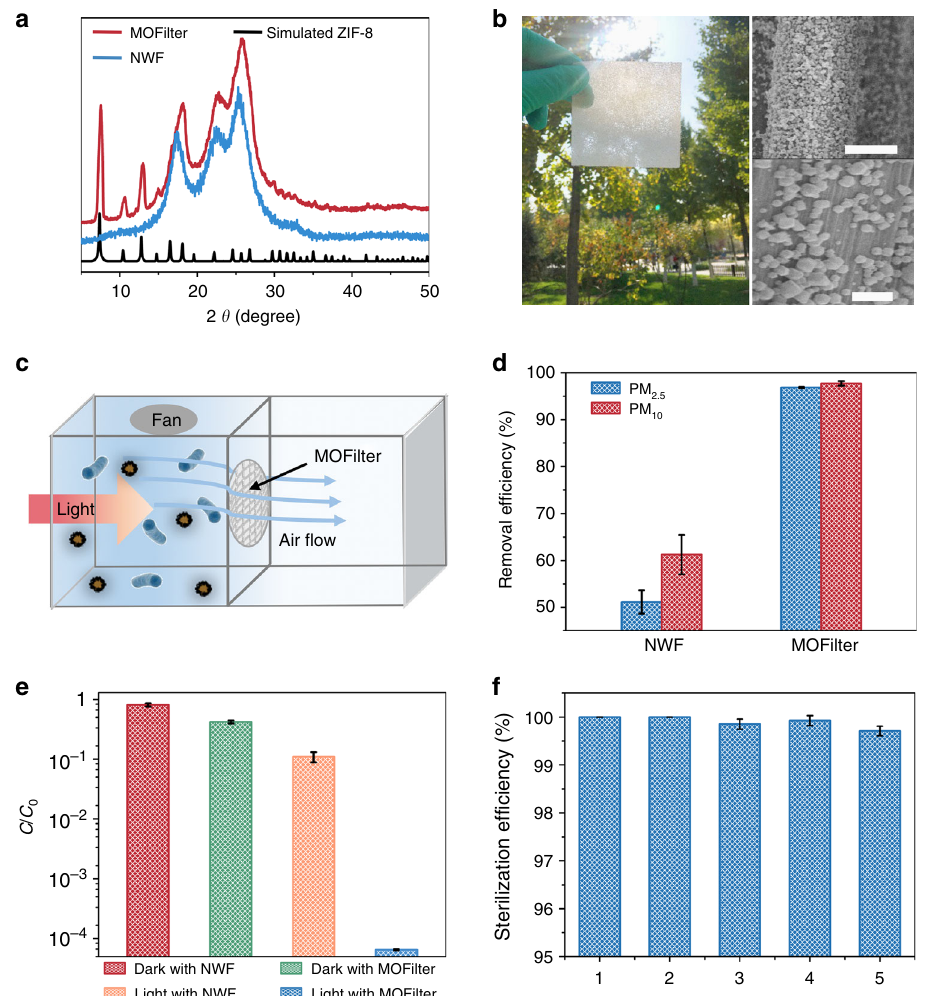
Fig. 4 Characterization of metal-organic framework (MOF)-based fi lter (MOFilter) and its air cleaning performance. a X-ray diffraction (XRD) patterns of non-woven fabric (NWF) and MOFilter. b Optical photo and scanning electron microscopy (SEM) images of MOFilter (scale bar, 5 μ m (top); 1 μ m (bottom)). c Schematic representation of the air cleaning system. d Comparison of the particulate matter (PM) fi ltration ef fi ciency between MOFilter and NWF. e Comparison of the air disinfection performance between MOFilter and NWF under light and dark conditions, respectively. f Air disinfection performance of MOFiter continuously used for fi ve cycles. The error bars are calculated via repeating the measurements for three